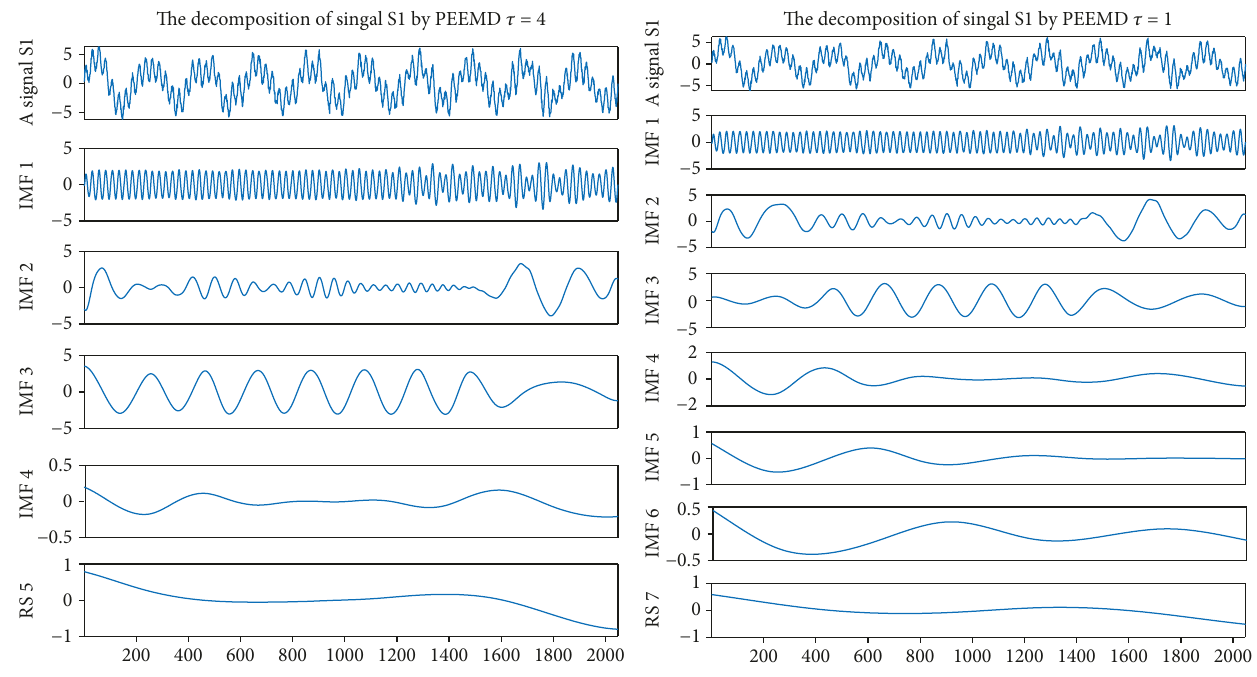
Figure 3: The decomposition of signal S Table 1: Parameters in the PEEMD.